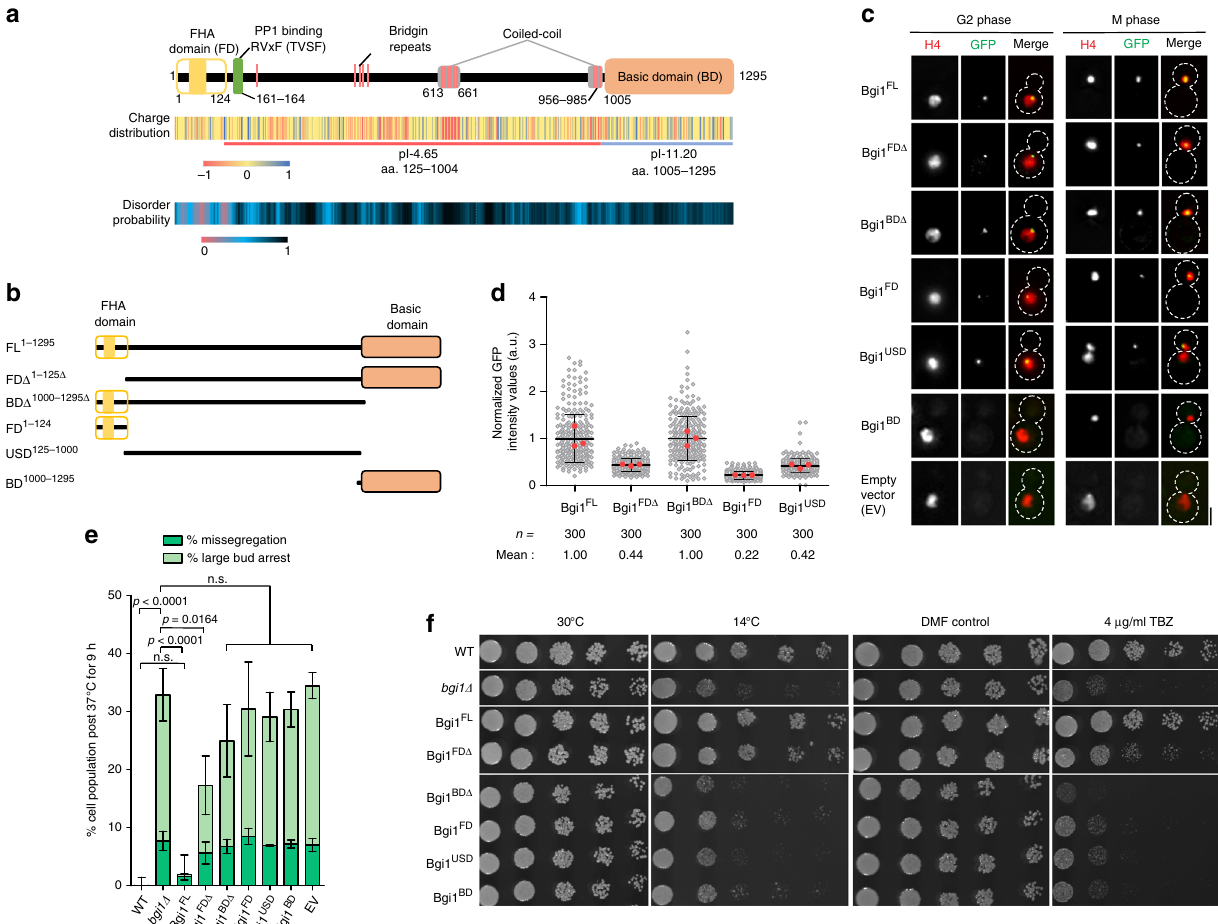
Fig. 5 The basic domain of bridgin is dispensable for its kinetochore recruitment but not for its function. a Schematic describing predicted features of bridgin. Charge distribution of amino acid residues was predicted with a window size of 2 using EMBOSS charge. The disorder probability of bridgin was calculated using IUPRED2A. b Schematic of domain deletion constructs of bridgin used in this study. Constructs were generated with a 3×FLAG-GFP tag at the amino terminus. c Representative cells of Bgi1 FL (SHR879), Bgi1 FD Δ (SHR913, SHR832::3×FLAG-GFP-BGI1 FD Δ ), Bgi1 BD Δ (SHR880, SHR832::3×FLAG-GFP- BGI1 BD Δ ), Bgi1 FD (SHR915, SHR832::3×FLAG-GFP-BGI1 FD ), Bgi1 USD (SHR916, SHR832::3×FLAG-GFP-BGI1 USD ), Bgi1 BD (SHR917, SHR832::3×FLAG-GFP-BGI1 BD ), and an empty vector (EV)/FLAG-GFP control (SHR918, SHR832::3×FLAG-GFP ) depicting localization of the mentioned GFP constructs in G2 and M phases.